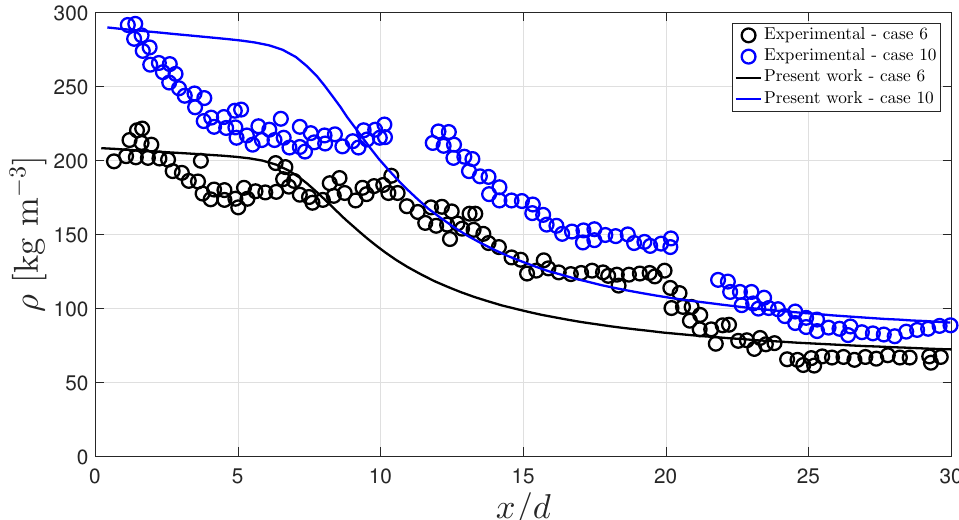
Figure 13. Axial density distribution comparison for cases 6 and 10.